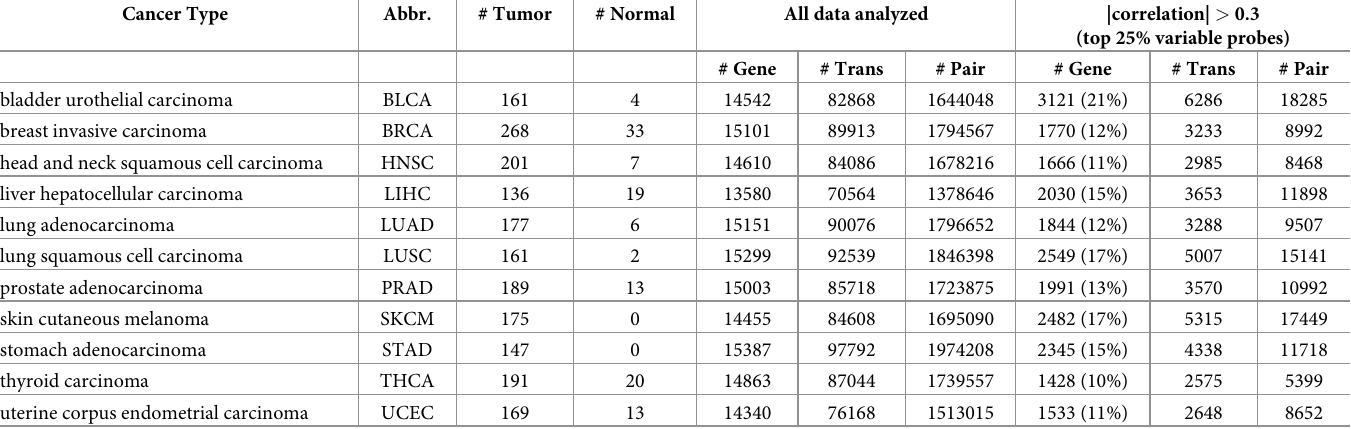
Table 1. The number of tumor samples, normal samples, genes, transcript isoforms, and isoform-probe pairs being analyzed across 11 cancer types.